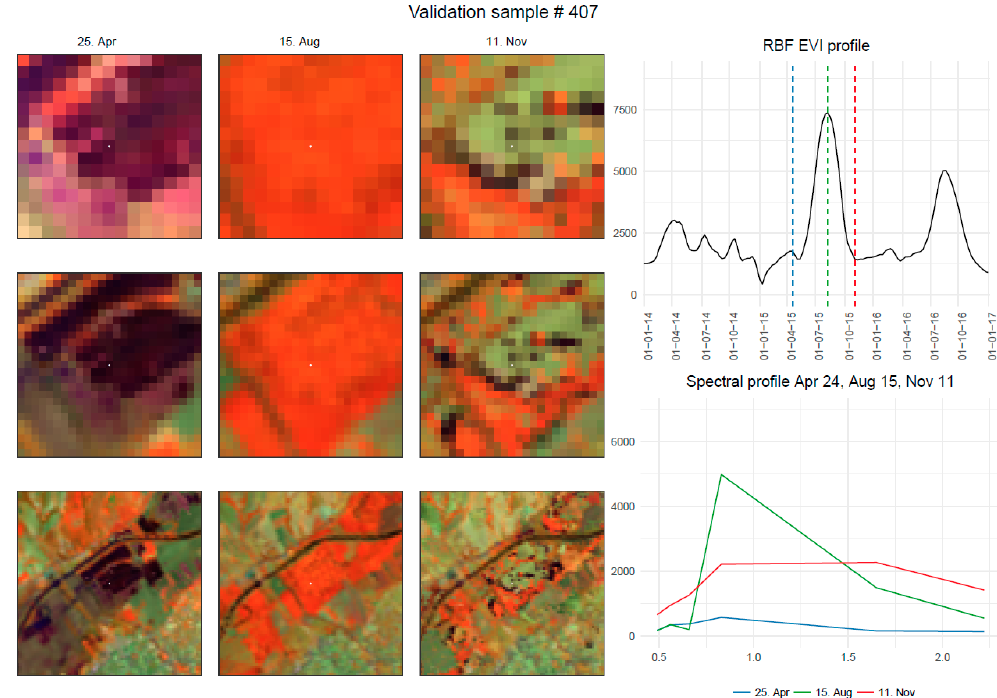
Figure A3. Validation pixel protocol for class semi-aquatic crop.